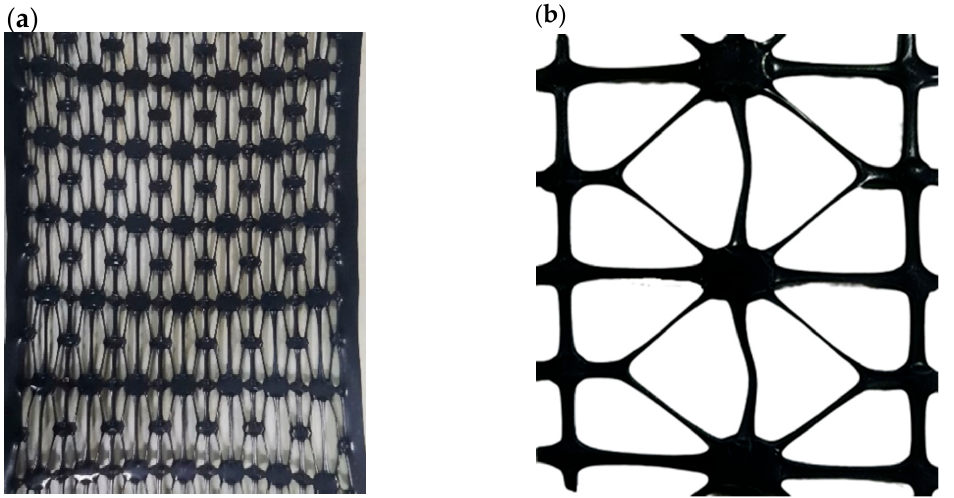
Figure 6. Performance-optimized multi-axial geogrid of circular-circular pre-punched holes. ( a ) Pre- punched plate after longitudinal drawing. ( b ) POMG formed fully.